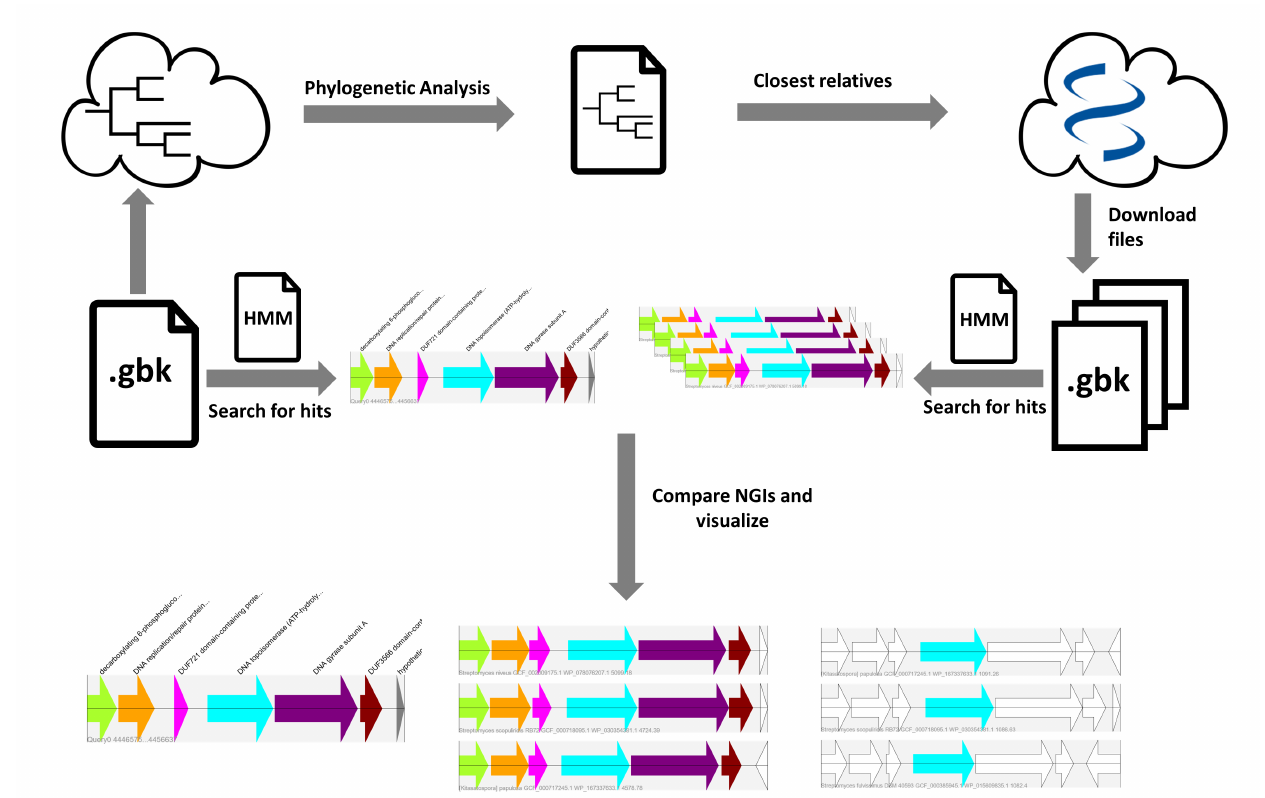
Figure 2. Schematic workflow. A phylogeny file needs to be created using autoMLST or an appropriate folder must be specified. Based on that, the 10 closest relatives are downloaded from the NCBI refseq database. Using an appropirate hmm or protein fasta file, NGIs are created, scored, and sorted. Finally, the results are saved as an svg